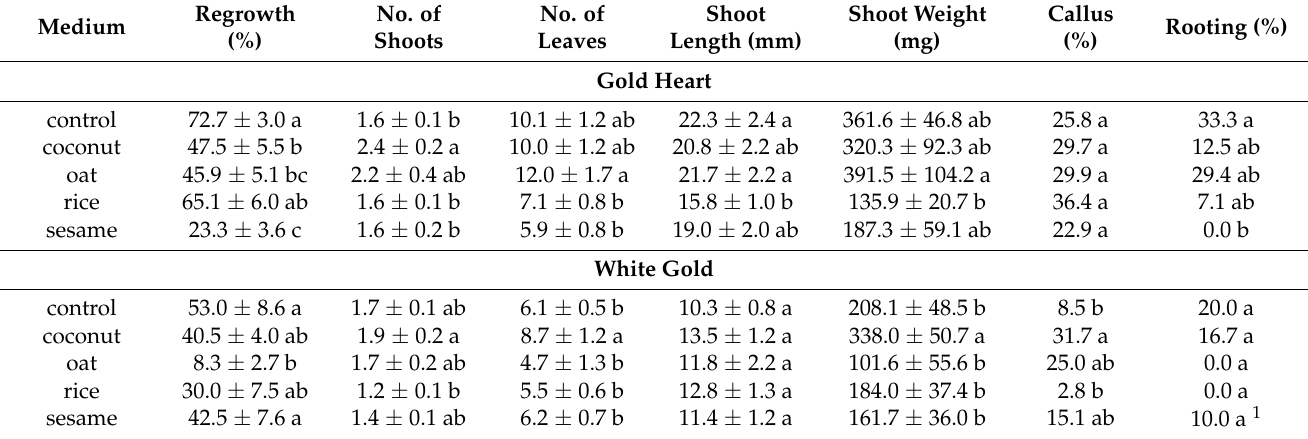
Table 3. Influence of preculture medium composition on the explant regrowth level (%), number of shoots and leaves produced by a single viable explant, shoot length (mm) and fresh weight (mg), as well as the share (%) of viable explants forming callus and roots in L. spectabilis after 10 weeks of post-rewarming culture.